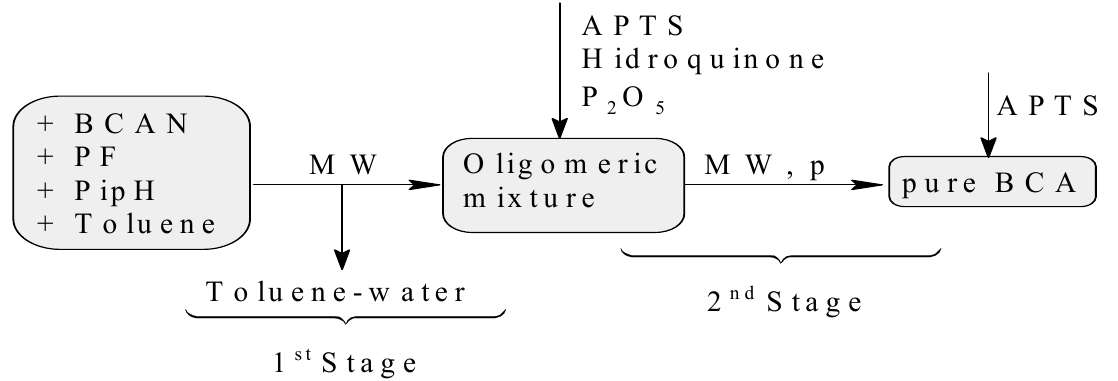
Figure 2. Direct synthesis of BCA assisted by microwave irradiation (MW).